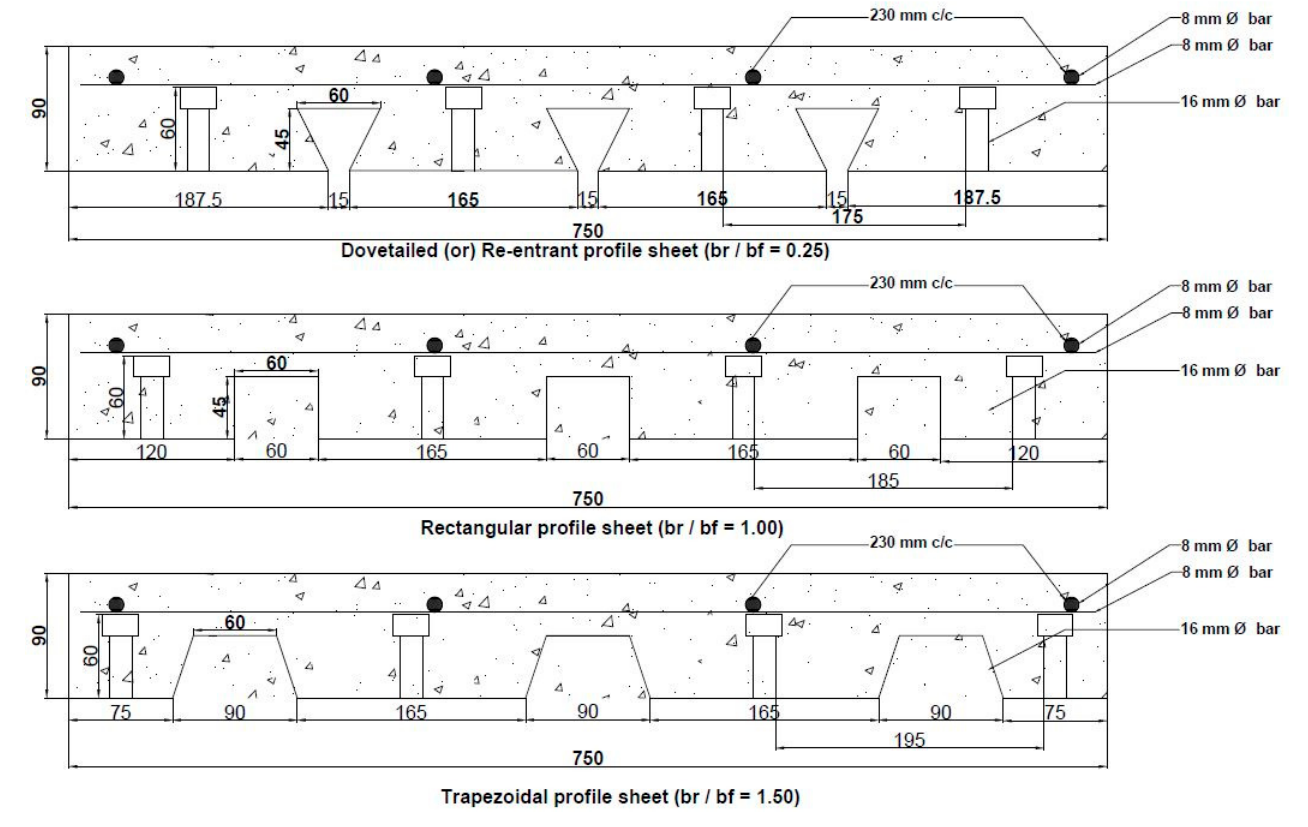
Figure 2. Cross sectional dimensions of profiled sheet.